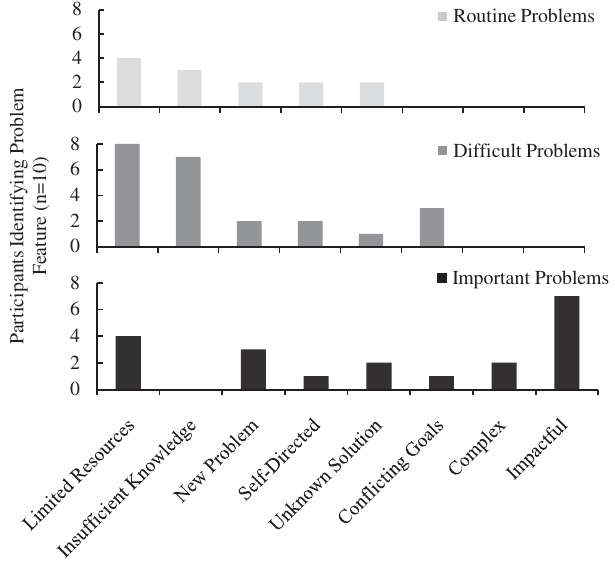
FIG. 4. Reported features of routine, difficult, and important problems.